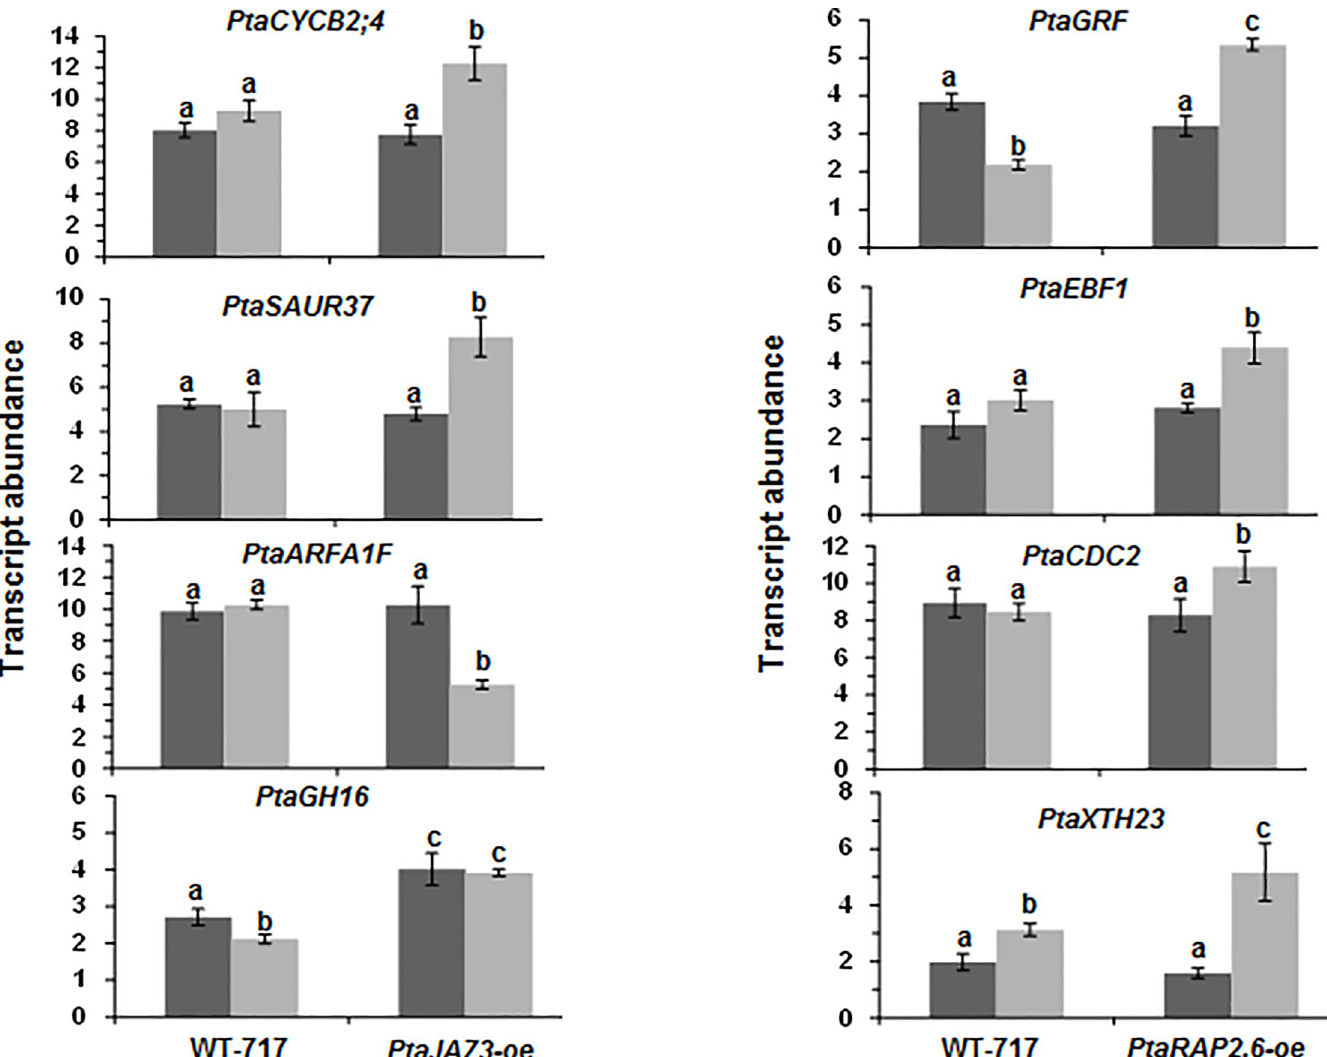
Fig 5. PtaJAZ3 and PtaRAP2 . 6 overexpression affects transcript abundance of the respective hub genes in response to PEG treatment. Transcript abundance was analyzed in roots of WT-717, PtaJAZ3-oe (left) and PtaRAP2 . 6-oe (right) transgenic lines under both control and PEG conditions. Hub genes associated with PtaJAZ3 and PtaRAP2 . 6 are shown in the left and right graph panels respectively. Two independent lines (four replicates per line) were used for each transgenic modification. Values show genotypes’ mean ± SEM ( n = 2). Different letters represent means that are statistically different ( P < 0.05) as determined by a one-way ANOVA followed by Tukey’s multiple range